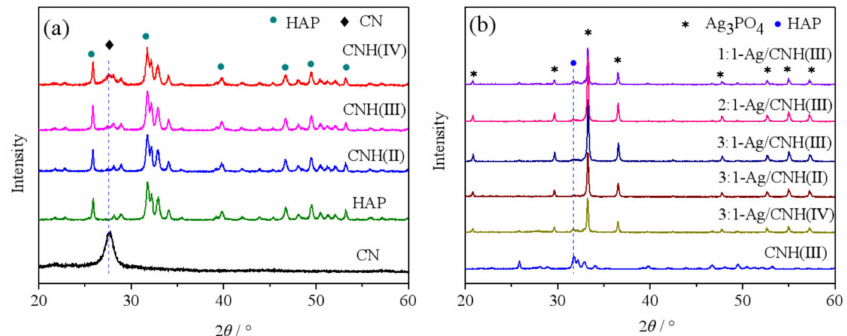
Figure 1. XRD patterns of ( a ) CN, HAP, CNH and ( b ) Ag/CNH.